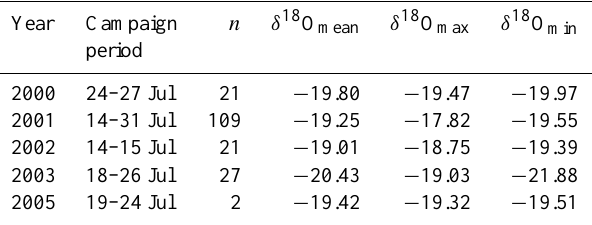
Table 2. Summary of δ 18 O mean and range in bulk water samples at the Kuannersuit Glacier river.